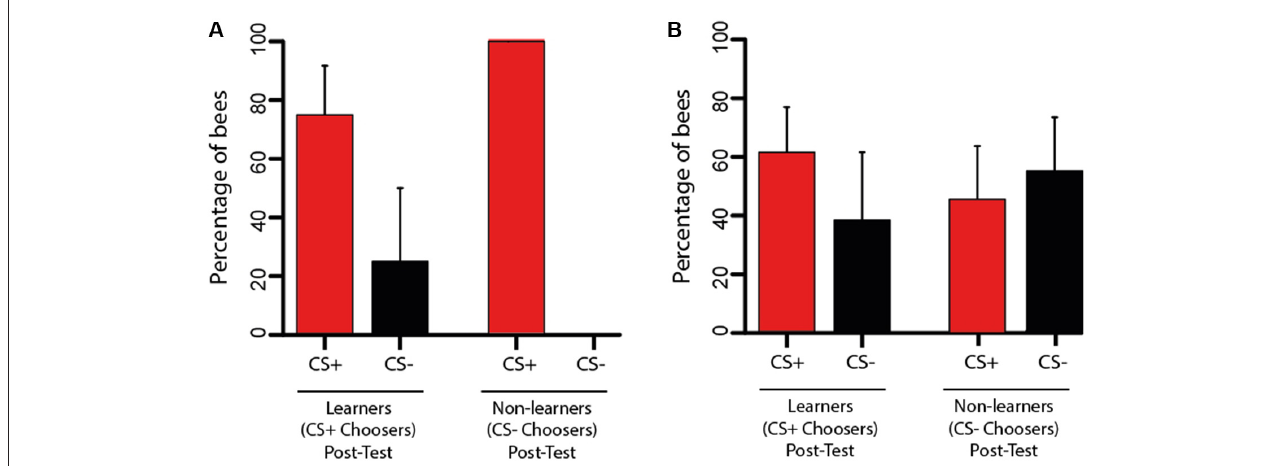
FIGURE 4 | Performance during the transfer test of Experiments 1 and 2. (A) Transfer test from Experiment 1. Bees trained in the VR setup were tested in the Y-maze. Bees having chosen the CS+ (learners; n = 12) or the CS − (non-learners; n = 9) in the post-test were considered for the analysis. The bars represent their choice of the CS+ or the CS − during the transfer test in terms of the percentage of bees within each choice category. The change in performance from the post-test to the transfer test was highly significant ( p < 0.01) as more bees chose the CS+ in the transfer test. (B) Transfer test from Experiment 2. Bees trained in the Y-maze were tested in the VR setup. Bees having chosen the CS+ (learners; n = 13) or the CS − (non-learners; n = 11) in the post-test were considered for the analysis. The bars represent their choice of the CS+ or the CS − during the transfer test in terms of the percentage of bees within each choice category. There was no significant change of performance between the post-test and the transfer test as both the percentage of bees choosing the CS+ and that of bees choosing the CS − were halved. The 95% confidence interval is shown in each case.